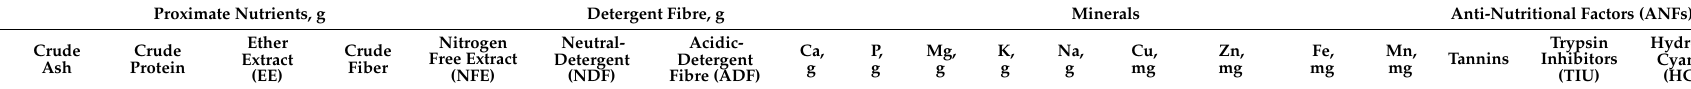
Table 2. Content of proximate nutrients, detergent fibre, some minerals, and anti-nutritional factors in Vicia sativa seeds (in 1 kg dry matter (DM) basal